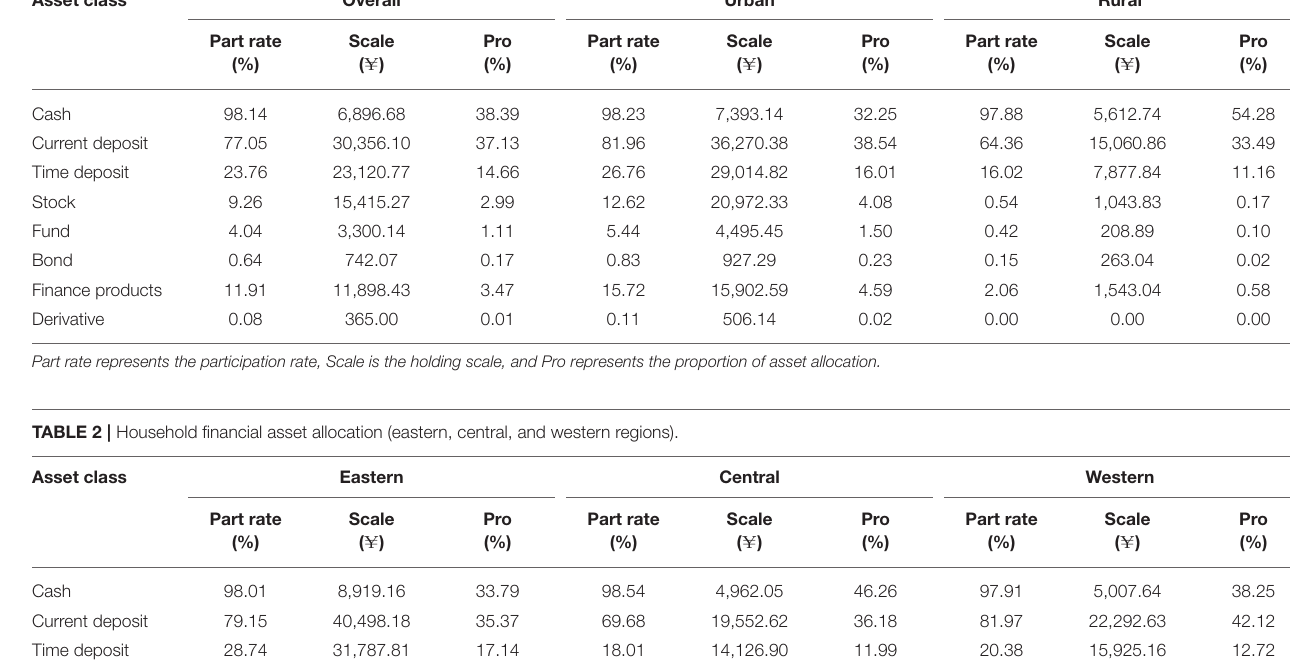
TABLE 1 | Household financial asset allocation (overall and urban and rural). Asset class